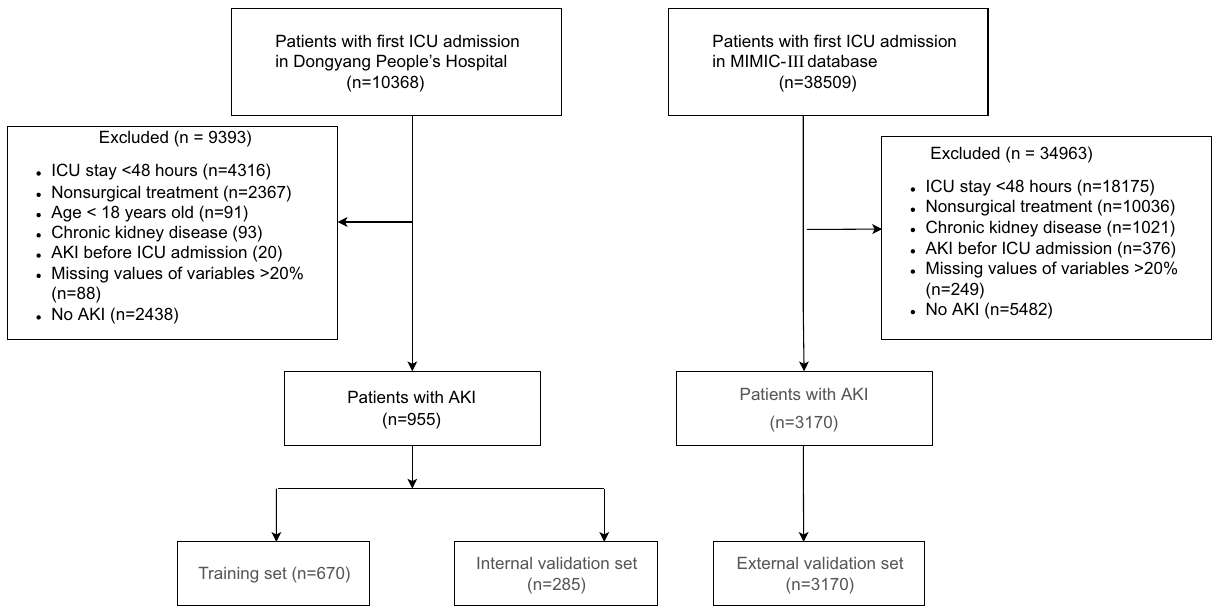
Figure 1. Flow chart of the study. ICU, intensive care unit; AKI, acute kidney